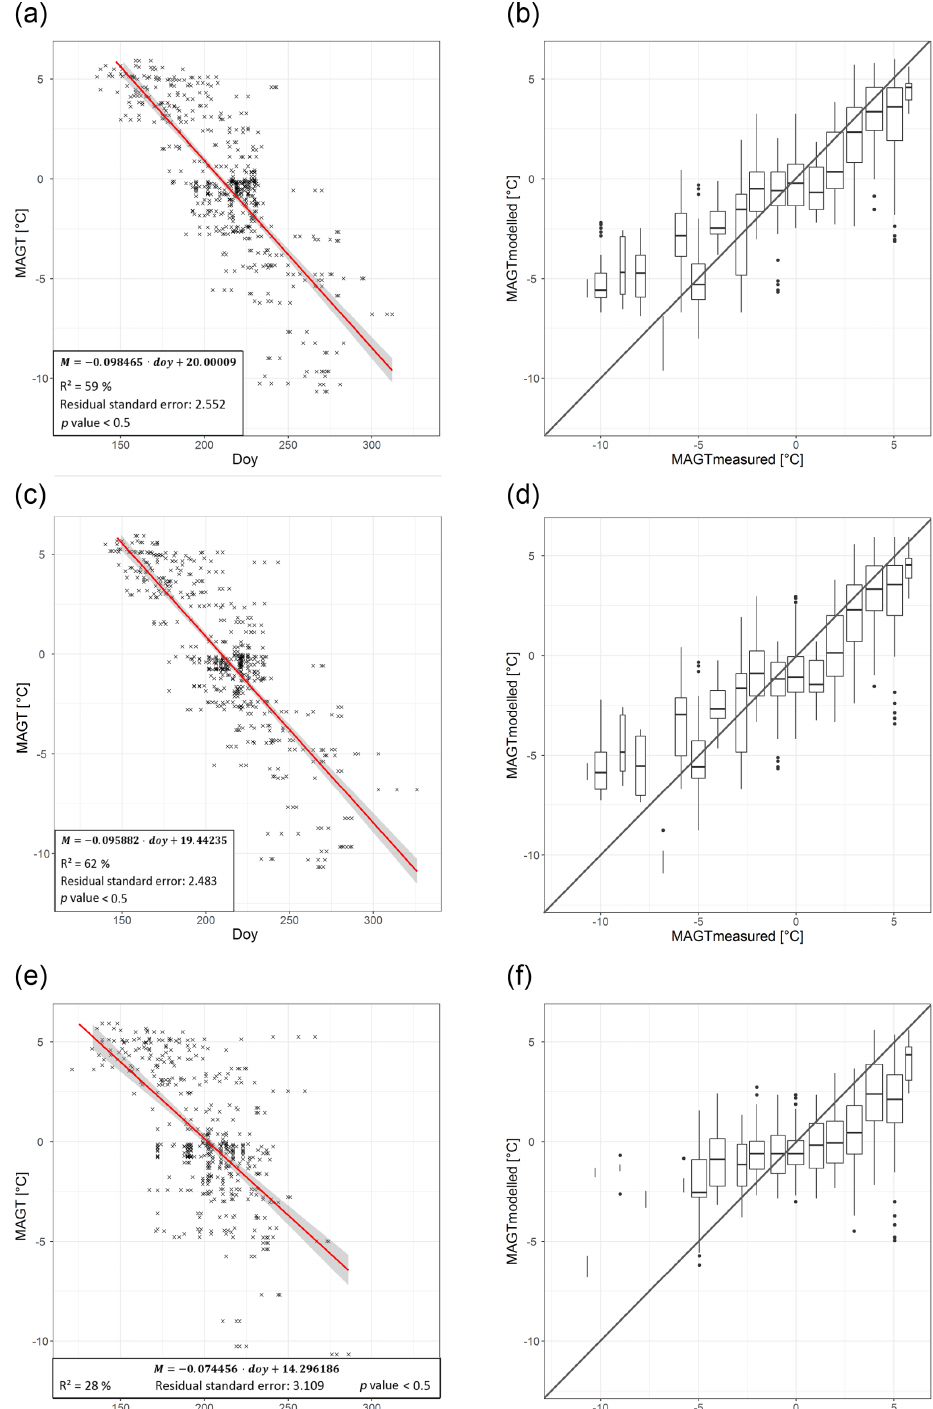
Figure 3. (a, c, e) Comparison of number of frozen days (doy – days per year) from satellite records and mean annual ground temperature for GTN-P boreholes (at the depth of the coldest sensor, years 2010–2012). The red line represents the linear fit. (b, d, f) Box plots of modelled versus mean annual ground temperature from GTN-P boreholes (at the depth of the coldest sensor, years 2007/2008 and 2008/2009). (a, b) ASCAT excluding snow melt days, (c, d) ASCAT with snow melt days, and (e, f) SSM/I.